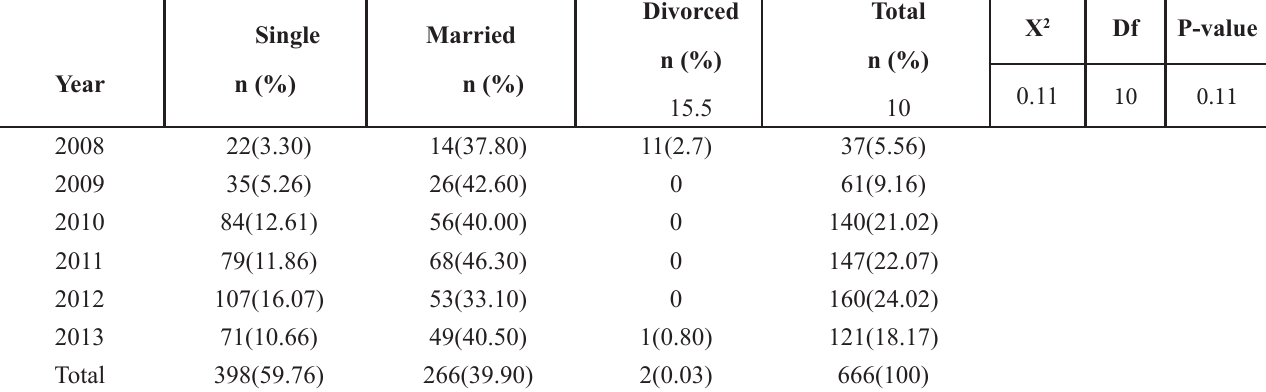
Table 4: Suicide rate based on marital status during 2008-2013 according to emergency unit records of Shahid Mohammadi Hospital